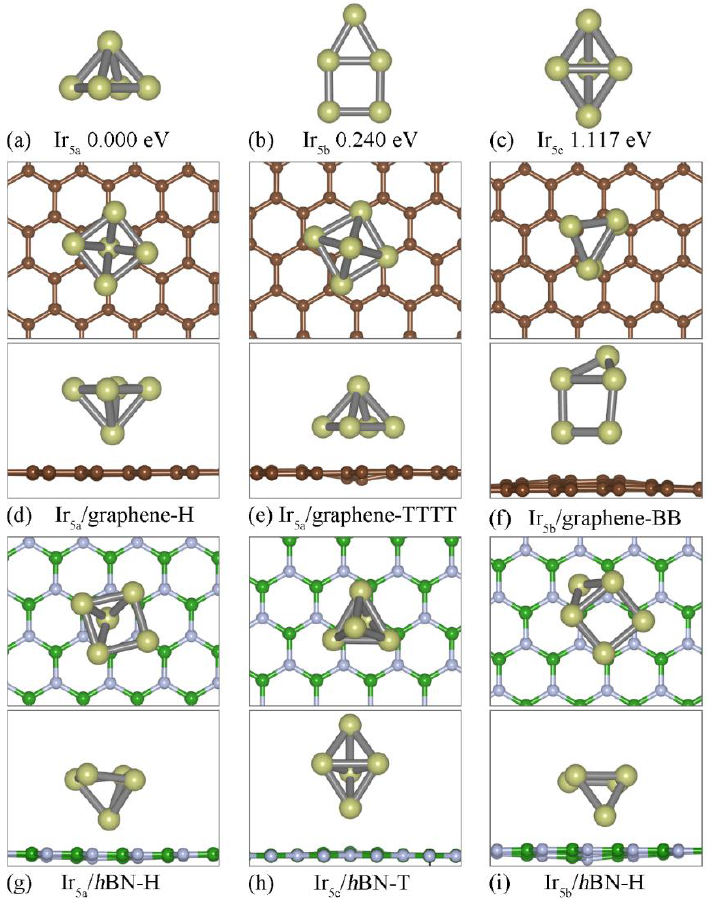
Figure 3. Atomic structures of the three relative stable atomic structures of the Ir 5 clusters for the free- standing ( a – c ), graphene (( d – f ), top and side view) and h BN (( g – i ), top and side view) substrate, respectively. We employ E coh and E det to further discuss the favorable Ir n clusters on the